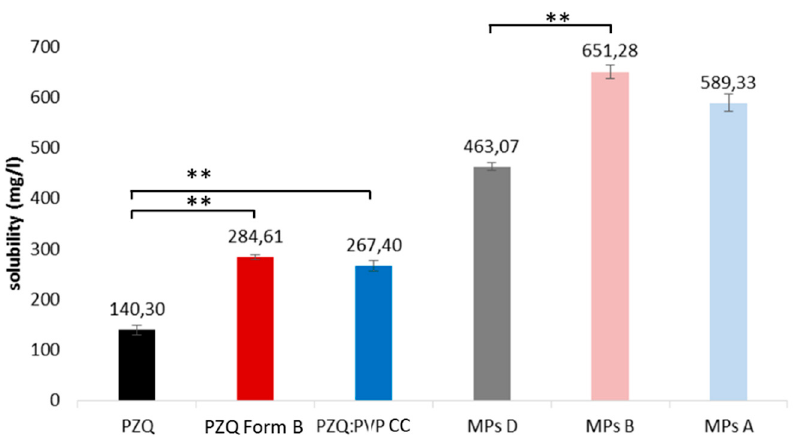
Figure 6. Comparison of the solubility data of the analyzed samples (**indicates significant difference).